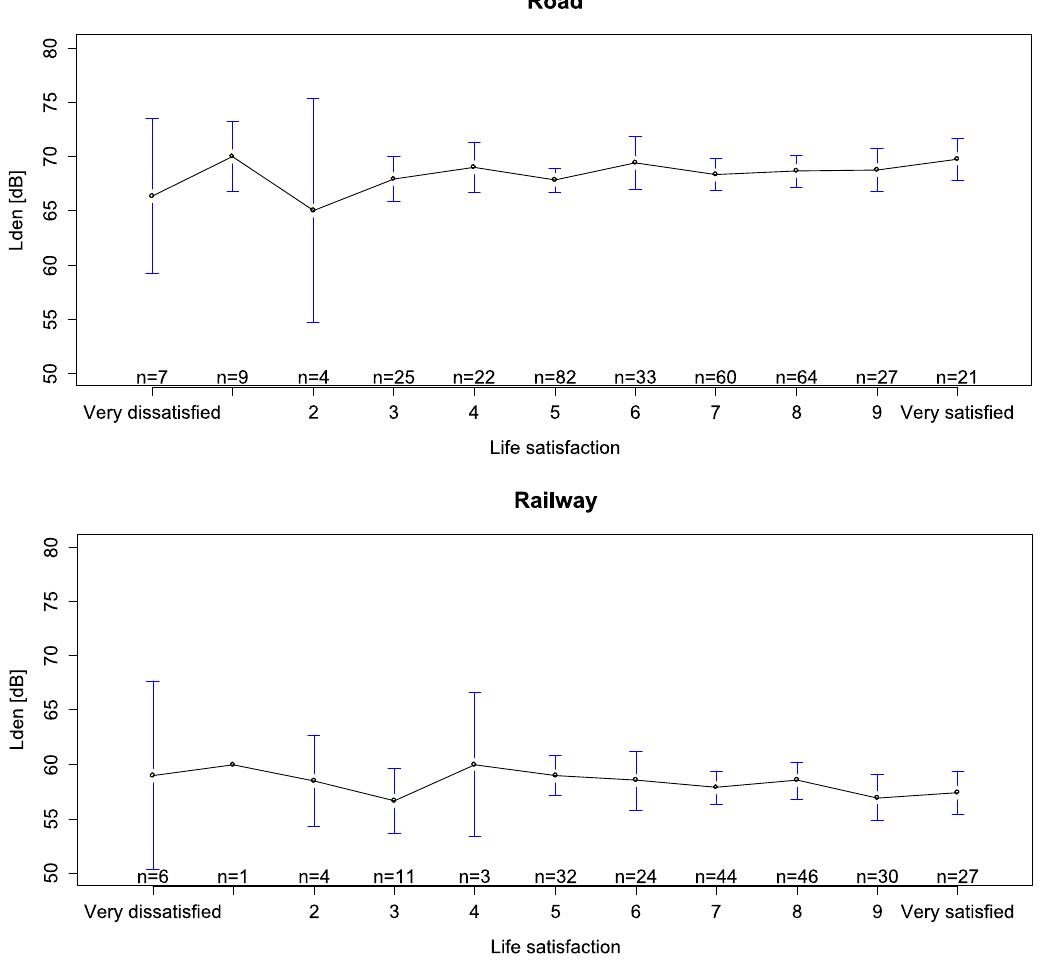
Table 4. Means, standard deviations, and correlations between observed